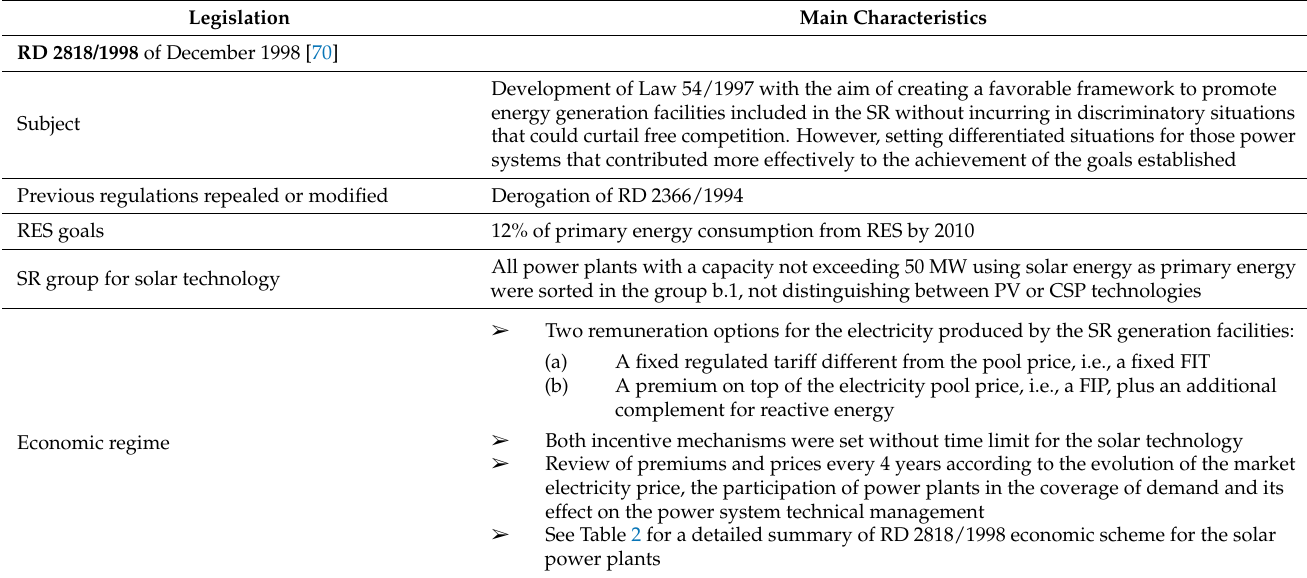
Table 1. Major characteristics of the different regulatory frameworks in force for the Spanish solar power systems in the period 1998–2004. Source: self-elaboration based on